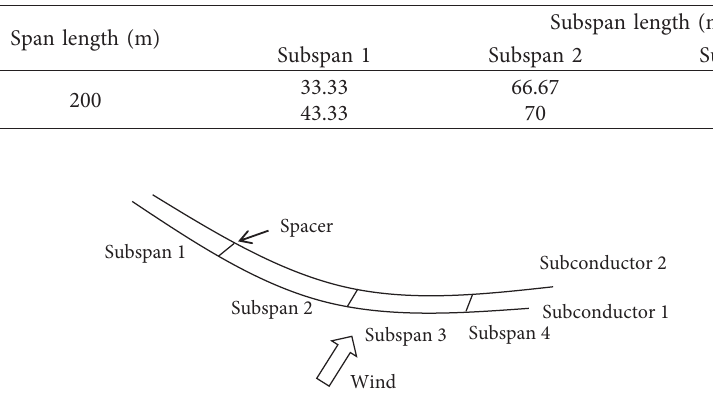
Figure 8: Numerical model of a twin bundle conductor with three spacers. Table 3: Global natural modes and frequencies of the